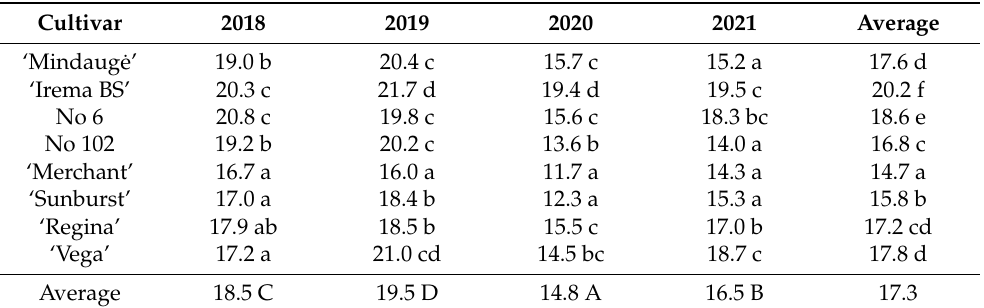
Table 6. Soluble solid content of sweet cherry fruits (%). Values marked with different small letters are statistically different within the columns and with the capitals—in the row ( p ≤ 0.05).